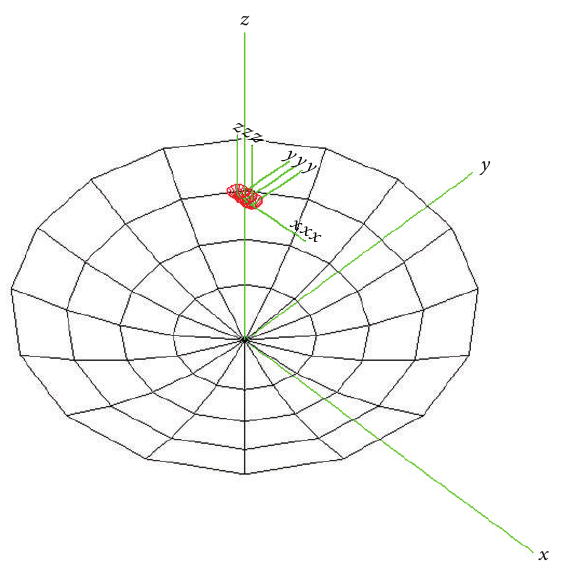
Figure 23: Single reflector feed with a linear array of horns located over the 𝑥